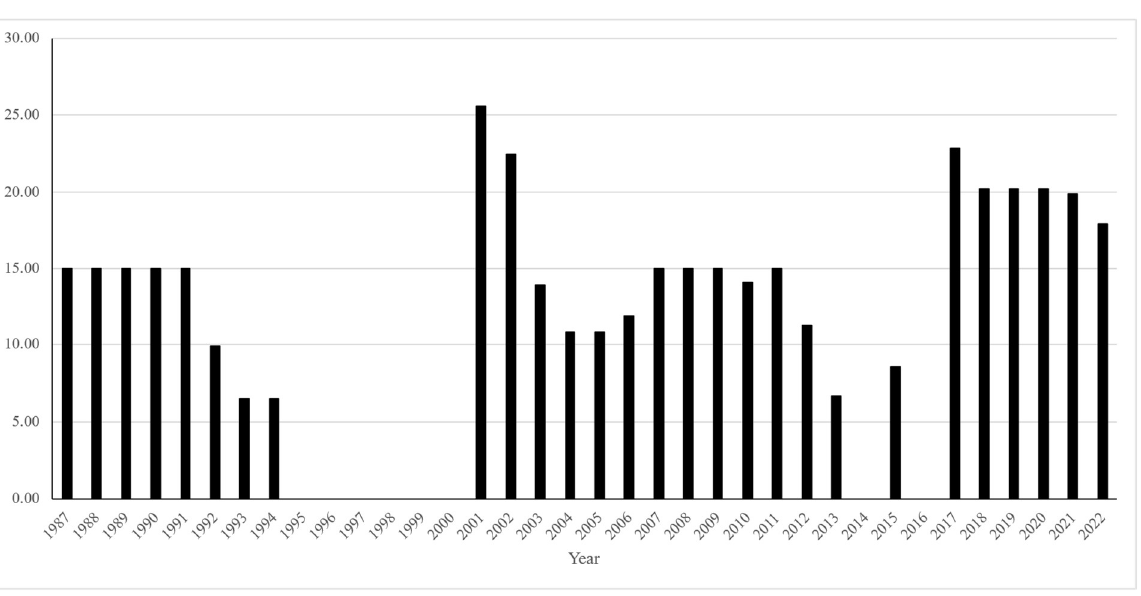
Figure 2. Historical antidumping and countervailing duties on Canadian softwood lumber by the United States. Source: Authors’ calculations using data from [8,9]. United States. Source: Authors’ calculations using data from